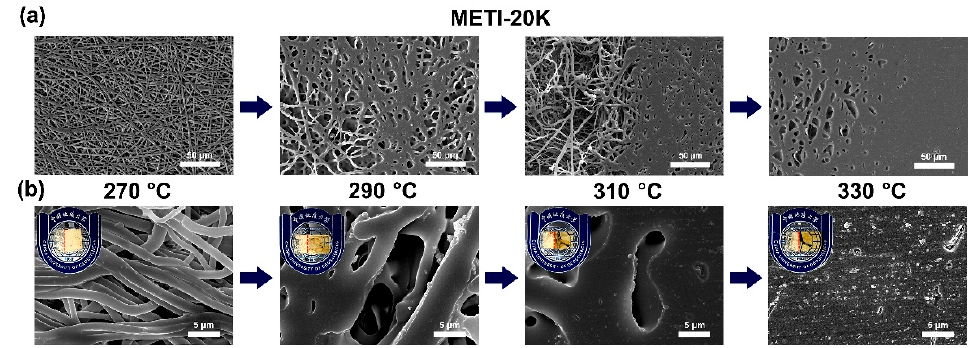
Figure 10. SEM images of METI-10K NFM after hot-pressing treatment. ( a ) 500×; ( b ) 4000×.